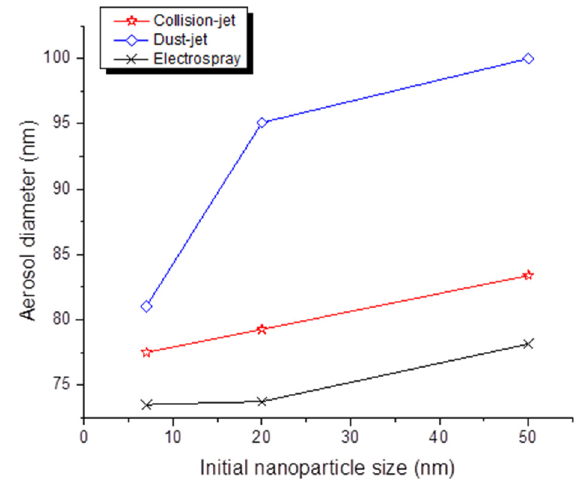
Figure 8. Average diameter of aerosols generated with the collision jet, dust jet and electrospray generators as function of initial NP size. For each NP size (7, 20 and 50 nm), aerosols were generated with the same number of particles, at 40,000, 160,000 and 250,000 particles/cm 3 for the collision jet, dust jet and electrospray, respectively.